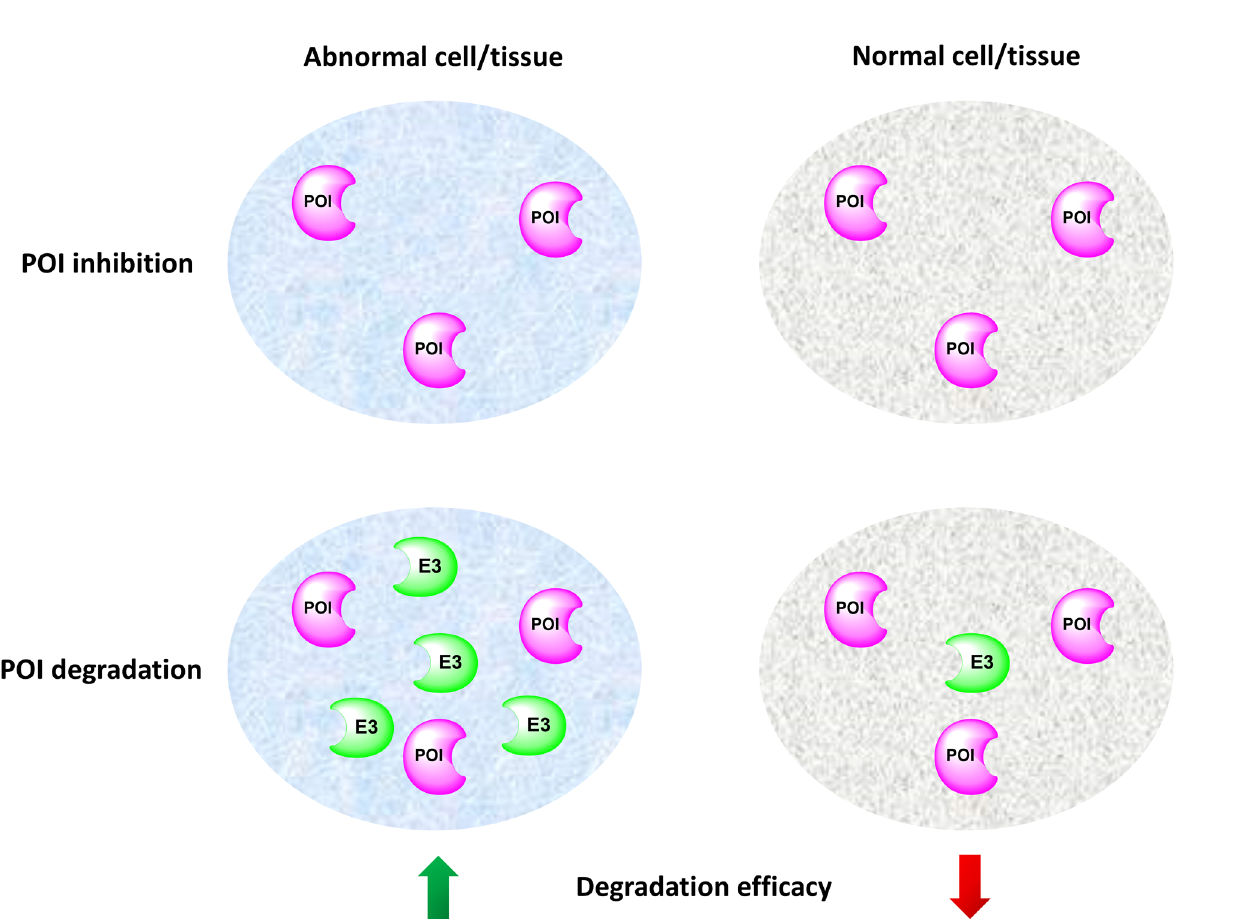
Figure 4. The utilization of PROTAC technology to reduce on-target drug